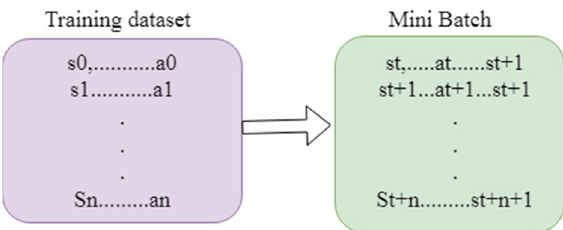
Figure 3. Data creation for the various